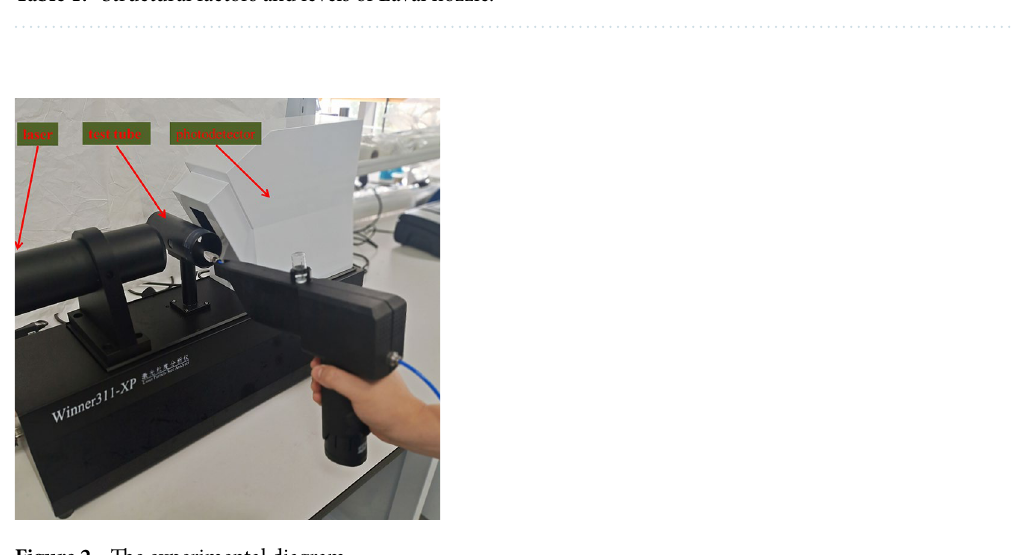
Table 1. Structural factors and levels of Laval nozzle.